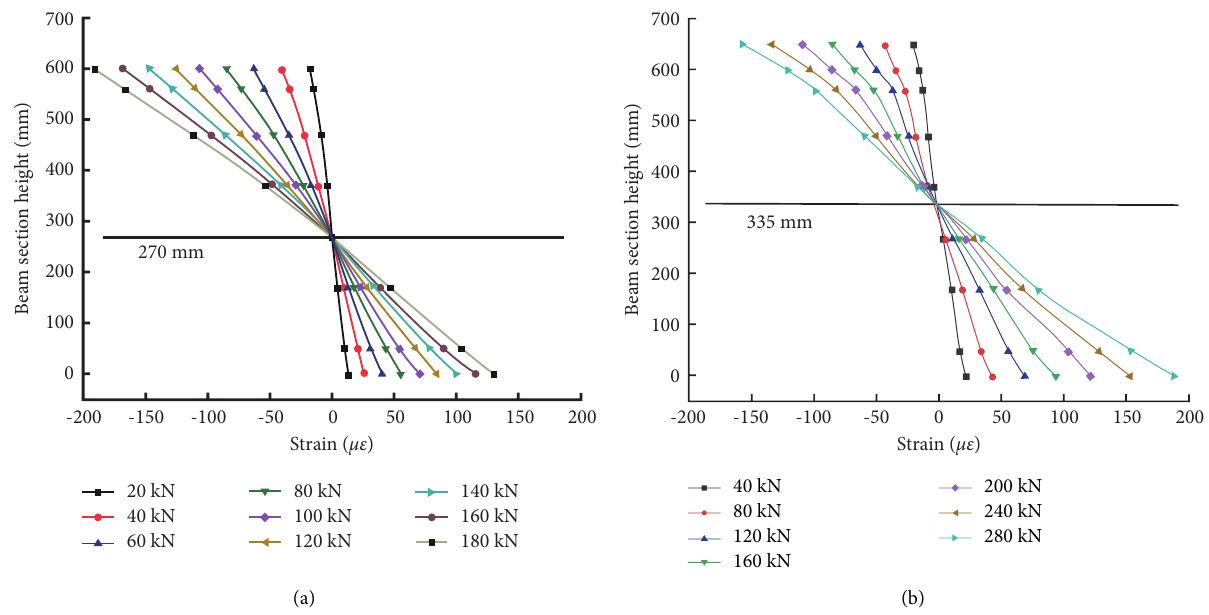
Figure 10: Strain distribution at the midspan section. (a) Sample S1. (b) Samples S2 and